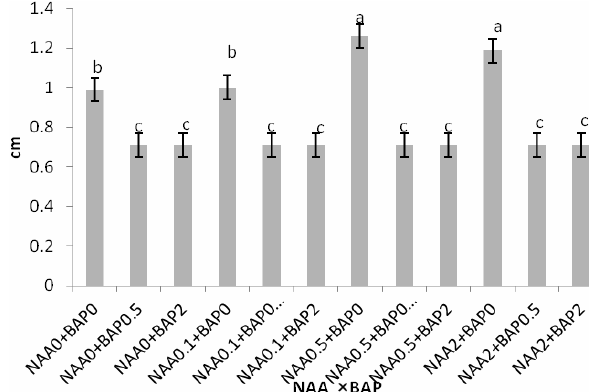
Fig. 10. The effect of interaction of NAA and BAP on root growth; Duncan’s multiple range test at 0.1% probability level